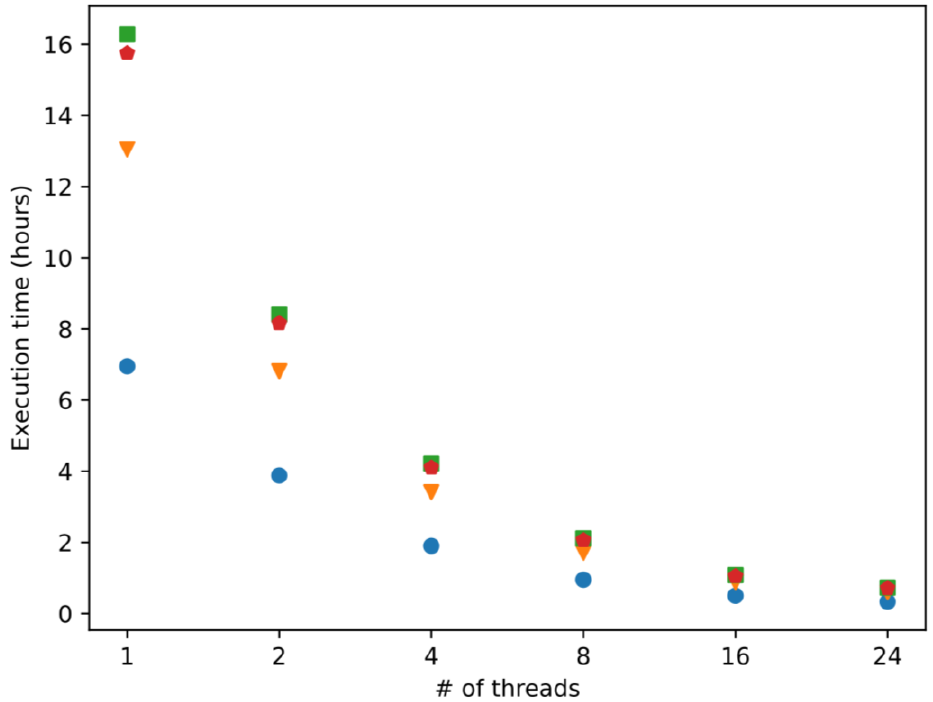
Figure 1. Execution times of four different implementations of the proposed algorithm. Blue circles correspond to the in-house SVM with Intel compiler. Orange triangles correspond to in-house SVM with Intel G++ compiler. Green squares represent LibSVM with Intel compiler. Red pentagons represent LibSVM with G++ compiler. # in the X axis, indicate the number of threads used in our